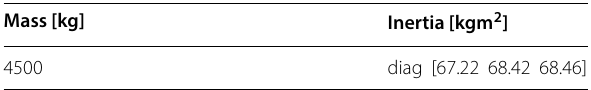
Comparison between the end effector position of the slave arm and the end effector position of the virtual arm (HILS 1) The positions of the end effectors of the slave and virtual arm along the x-axis are plotted in Fig. 13. Because the positions of both arms along the y and z axes were almost constant and identical, only the positions along the x-axis are presented. Because the position of the virtual arm was sent to the slave arm, and it was used in the slave arm control (the third term of the right hand side of 2), the motion of the virtual arm almost corresponds to the motion of the slave arm (note that the time delay was zero in HILS 1).